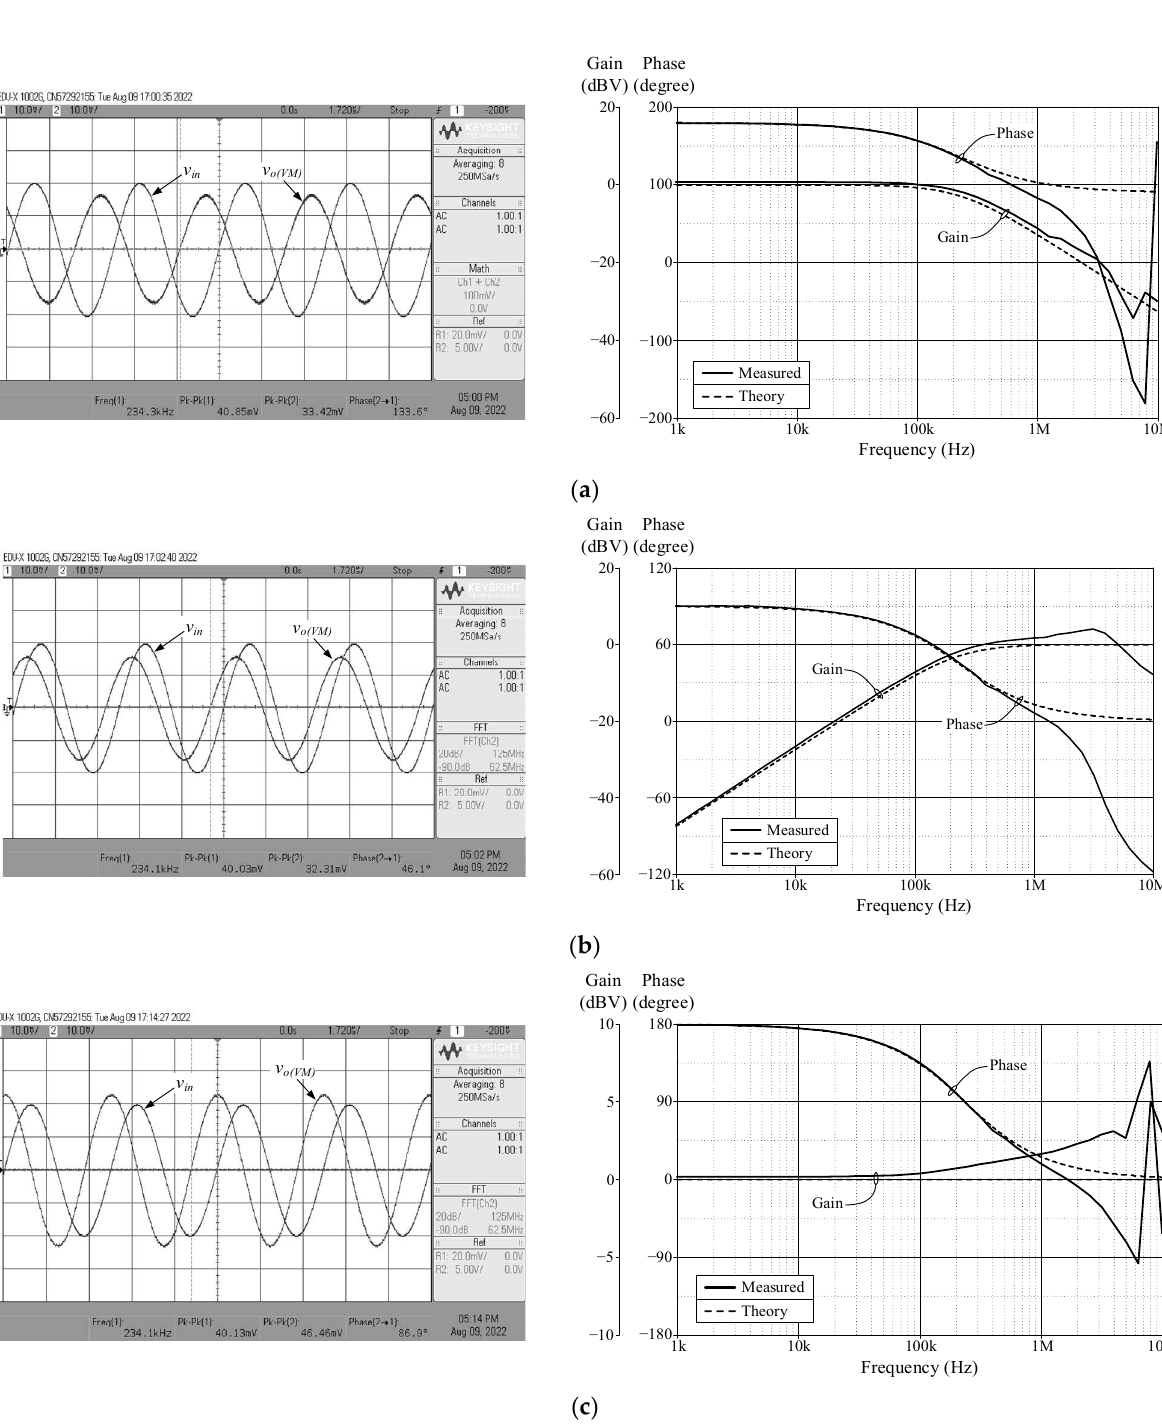
Figure 13. Measured time and frequency responses of the proposed VM filter: ( a ) LP; ( b ) HP; and ( c ) AP.